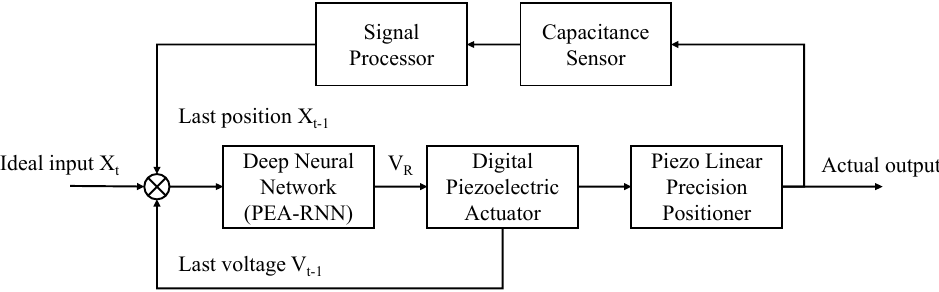
Figure 7. Schematic diagram of feedforward control of